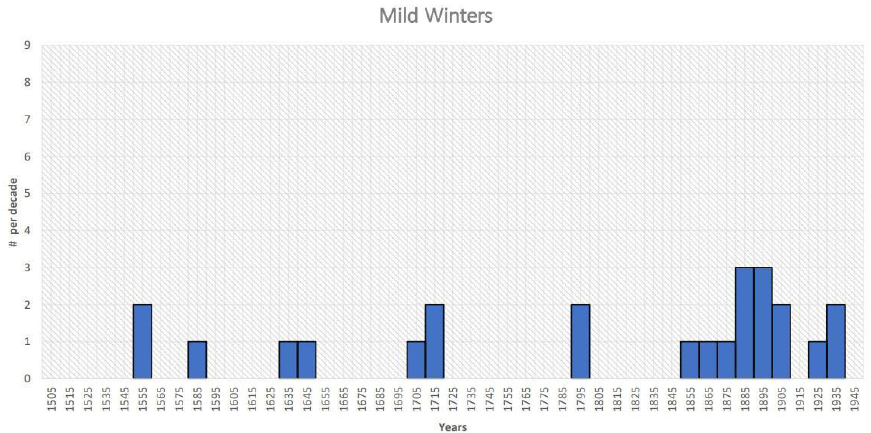
Figure 2. Decadal numbers of harsh winters ( top ) and mild winters ( bottom ) in Transylvania for the period of 1500 to 1950.